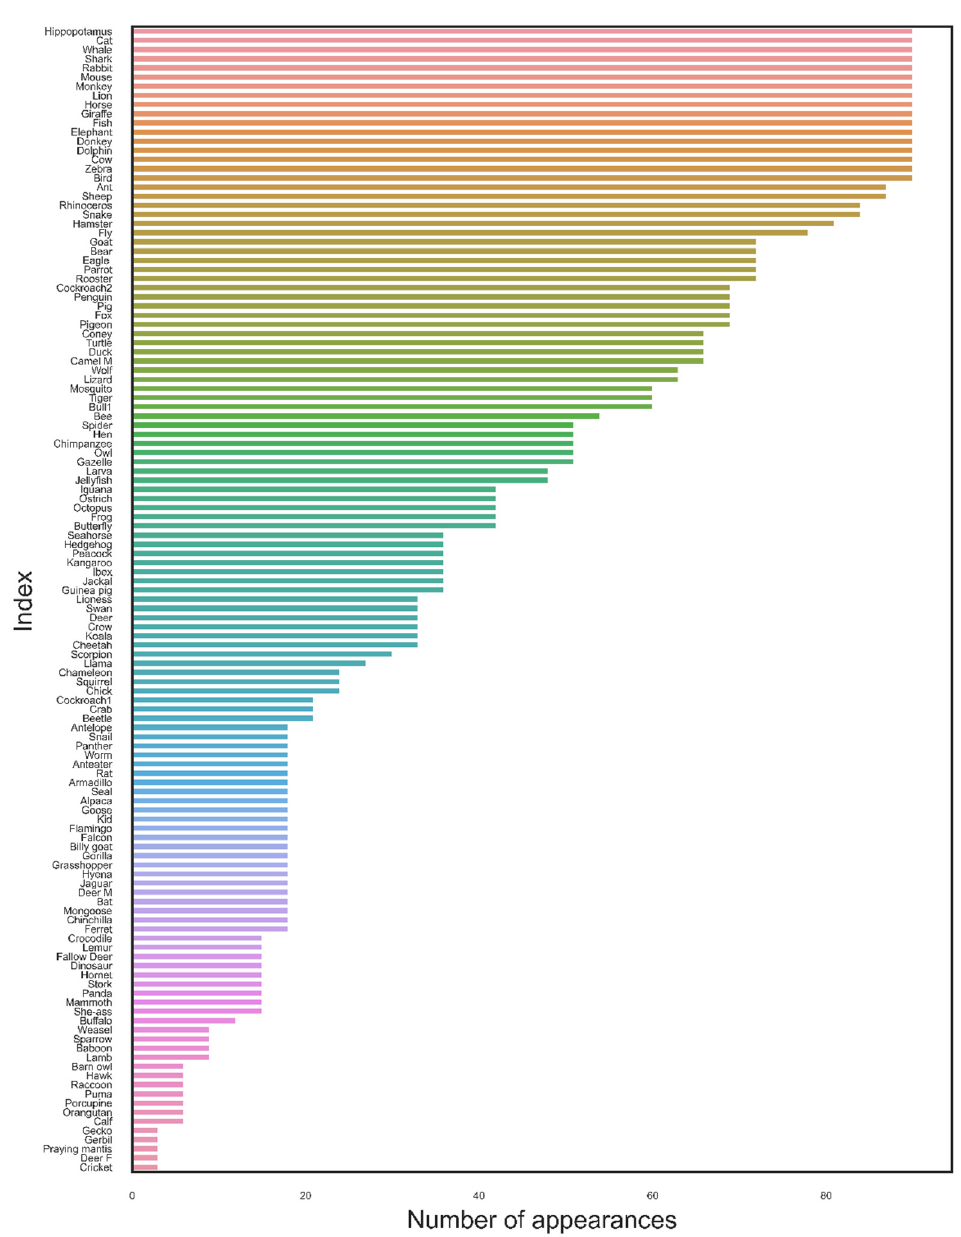
Figure A3. The number of object-based dynamic scores that each word received in 90 networks where the free parameters of the object-based dynamic were WS, MS, and the threshold.